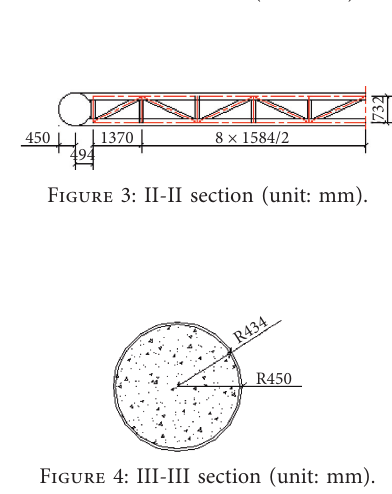
Figure 2: I-I section (unit: mm).